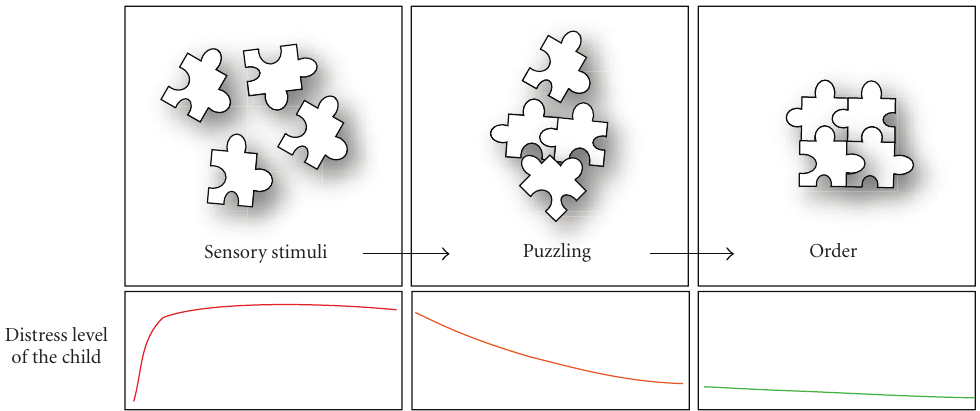
Figure 1: Children with autism need to puzzle their perceptions together to create order. Before puzzling, the child feels distress. After puzzling, the order makes the child feel at